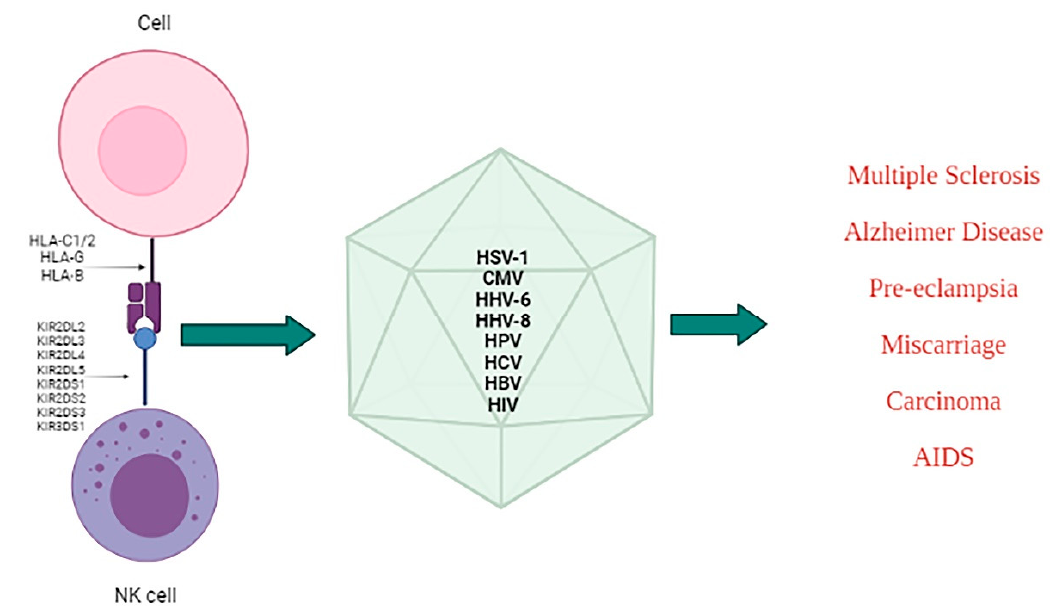
Figure 6. Schematic representation of KIR/HLA class I association to viral susceptibility and diseases. The presence of particular activating (KIR2DL4, KIR2DS1, etc.) and inhibitory (KIR2DL2, KIR2DL3, etc.) KIRs, together with their specific ligands (HLA-C, HLA-G, and HLA-B), is involved in some viral infections’ susceptibility and outcome (HSV-1, CMV, and HIV, etc.), leading to multiple diseases like Multiple sclerosis, Alzheimer disease, Pre-eclampsia, Miscarriage, Carcinoma, and AIDS. Table 2. Virus and KIRs/HLA association and possibly related diseases.